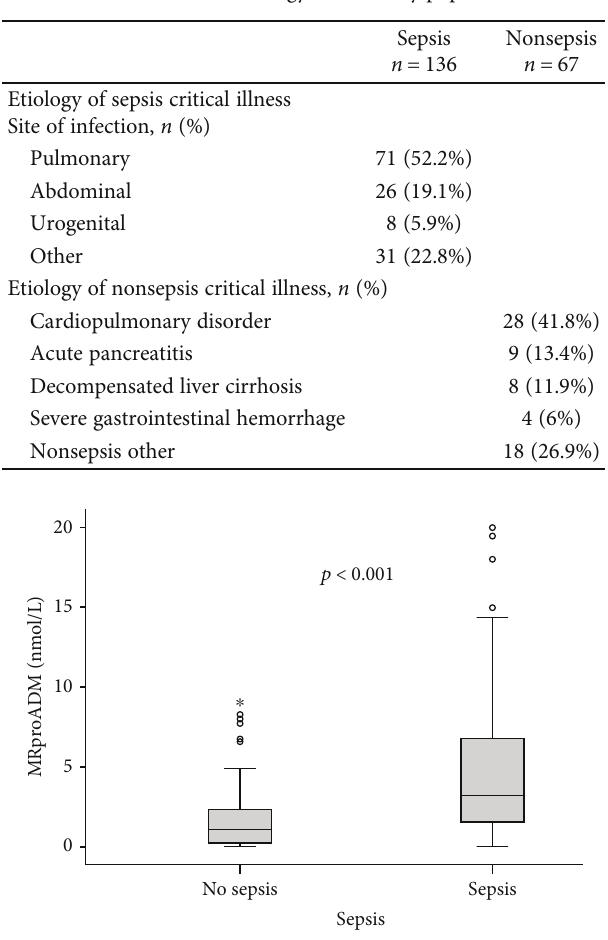
Table 1: Disease etiology of the study population.